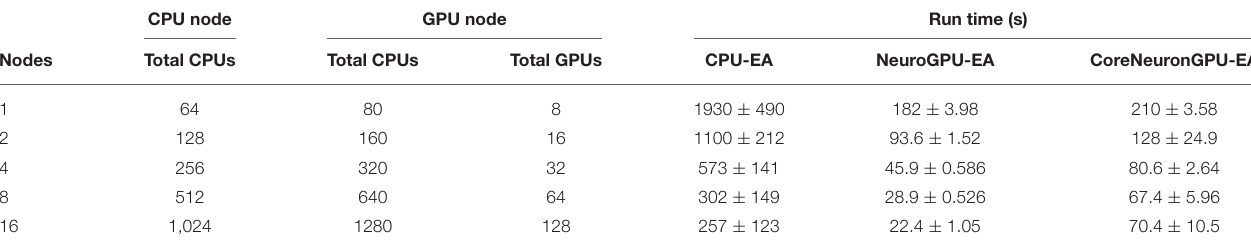
TABLE 2 | Compute scales and problem fixed: Stimuli and electrophysiological score functions are fixed to 8 and 20, respectively. CPU node GPU node Nodes